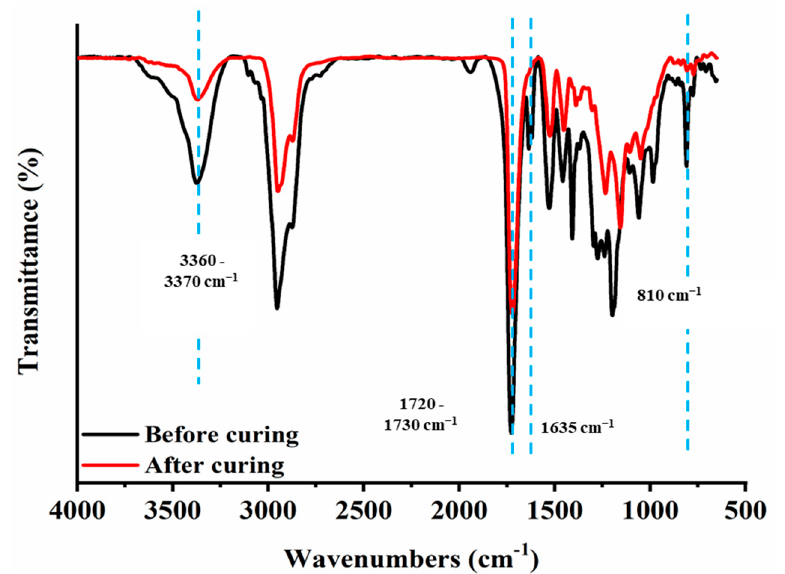
Figure 4. FT-IR spectra of P-IBOA coatings (before and after curing).